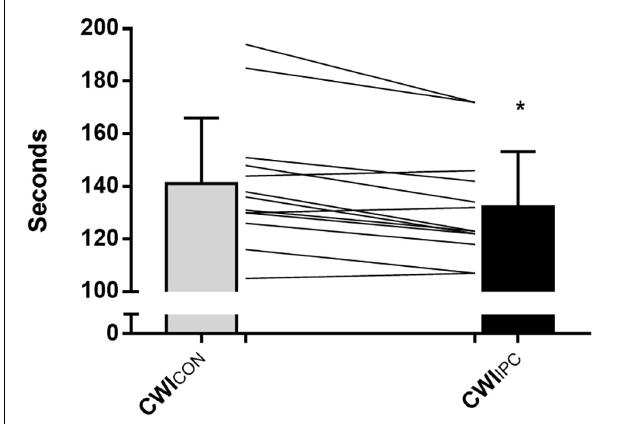
FIGURE 2 | Time (s) under pain during a cold-water immersion test under normal conditions (CWI CON ) and following IPC treatment (CWI IPC ). The time under pain represented the total time (s) from when the participant first reported pain after introduction of the cold stimulus to when the pain was completely gone after removal of the cold stimulus. Data is represented as mean ± SD, and * represents a statistically significant difference ( P < 0.05).